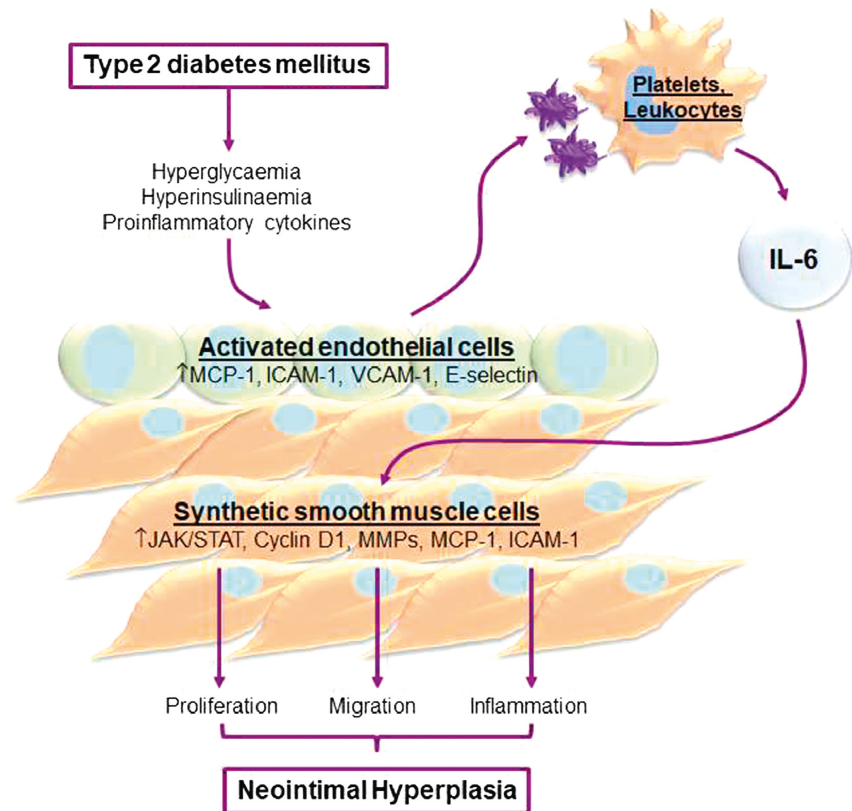
Figure 1: Cellular and molecular signals linking type 2 diabetes mellitus and neointimal hyperplasia. Type 2 diabetes is associated with circulating hyperglycaemia and hyperinsulinaemia and increased proinflammatory cytokines. Activated endothelial cells upregulate MCP-1, ICAM-1, VCAM-1, andE-selectin.ThisincreasesrecruitmentofplateletsandleukocyteswhichreleaseIL-6.ThiskeycytokineactsonsmoothmusclecellstoactivateJAK/ STATsignalling to trigger upregulation of cyclin D1 and matrix metalloproteinases (MMPs) and further increase MCP-1 and ICAM-1 induction. These molecular signatures are characteristic of synthetic smooth muscle cells, leading to the development of neointimal